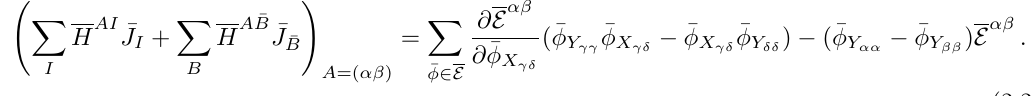
Figure 2 . Graphical representation of the vanishing of the H -constraints for a ((cid:3) A ; (cid:22)(cid:3) (cid:22) The H -constraints for ((cid:3)